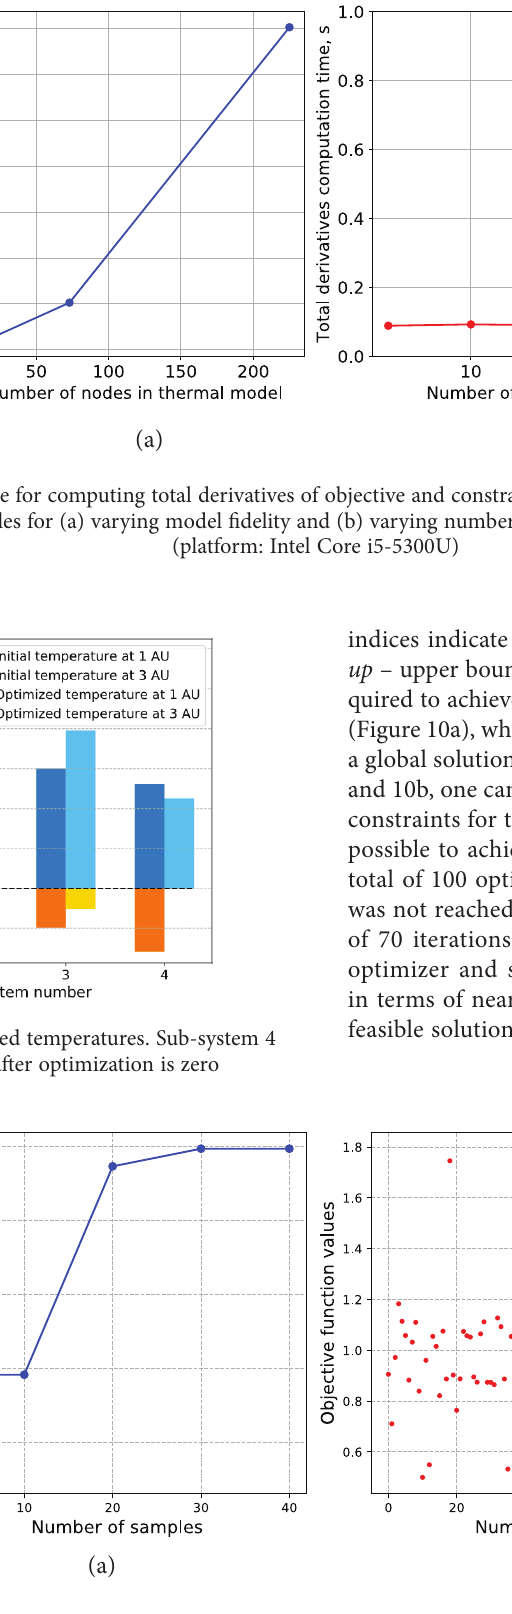
Figure 9. Evolution of best objective value with (a) number of samples and (b) plot of all objective